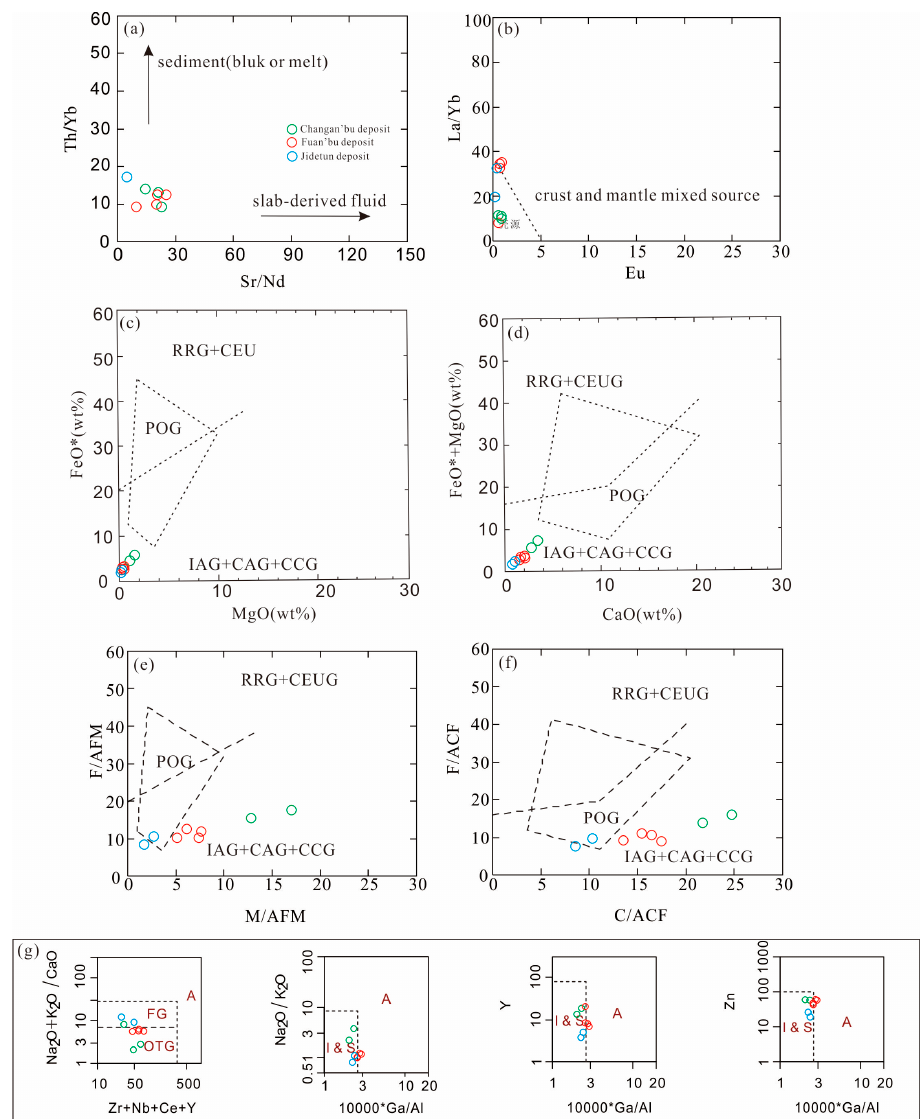
Figure 9. Tectonic setting and source discrimination diagrams for ore-hosting rocks from the Chang’anbu, Fu’anbu, and Jidetun deposits [5,6,13,30,35,36].( a ) Sr/Nd–Th/Yb; ( b ) Eu–La/Yb; ( c ) MgO–FeO; ( d ) CaO − FeO + MgO; ( e ) M/AFM–F/AFM; ( f ) C/ACF–F/ACF; ( g ) A–I–S type discrimination.